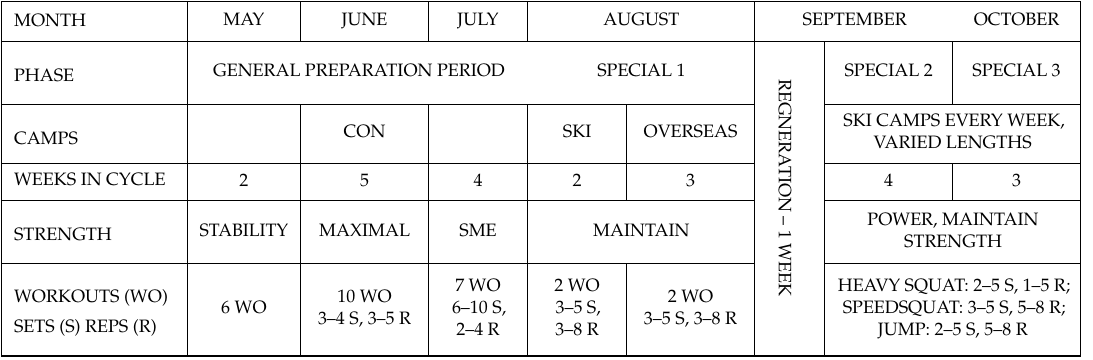
Table 1. Periodization of strength training in the general physical preparation (GPP). CON: conditioning camp, SKI: ski racing camp, RG: regeneration